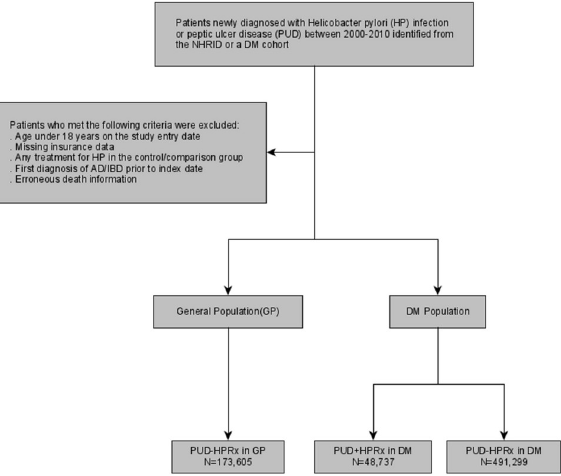
Fig 1. Flow chart of the study design. PUD+HPRx, peptic ulcer disease with Helicobacter pylori treatment; PUD-HPRx, peptic ulcer disease without Helicobacter pylori treatment; DM, diabetes mellitus; AD, autoimmune disease; IBD, inflammatory bowel